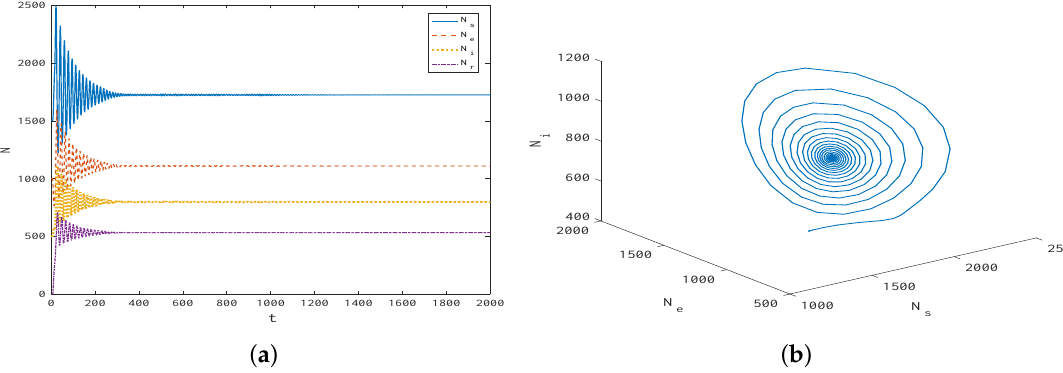
Figure 3. Local asymptotic stability of the endemic equilibrium point H ∗ = ( N ∗ s , N ∗ e , N ∗ τ = 4.3526 < τ 0 . ( a ) Time response diagram of N s , N e , N i and N r ; ( b ) Phase diagram of N s , N e and N i